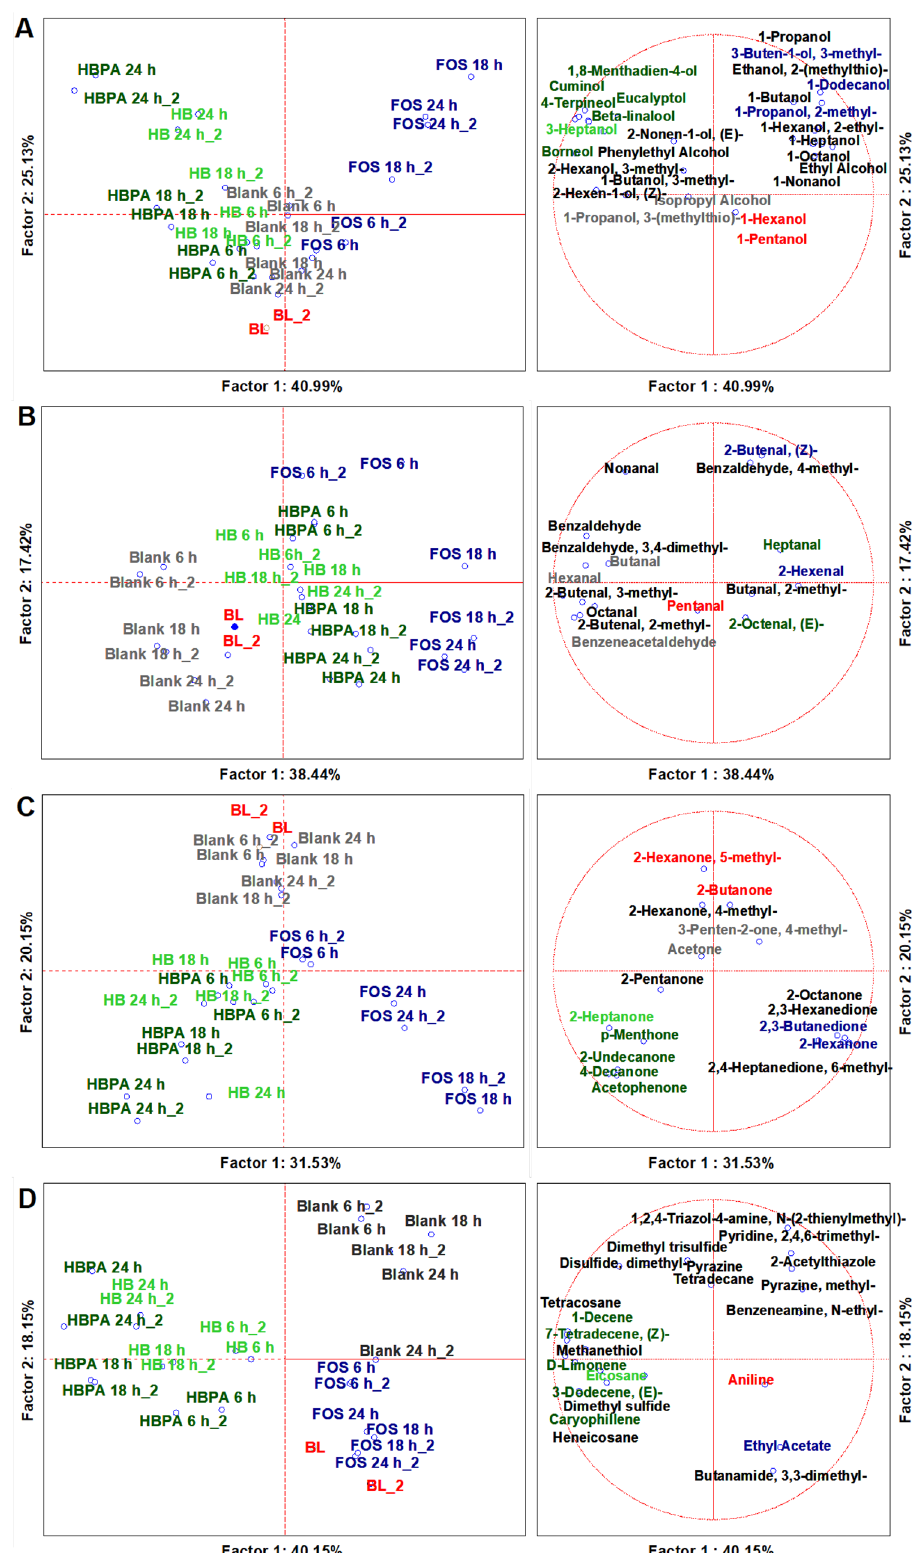
Figure 4. PCAs of the volatilome sorted by chemical classes of significant (ANOVA p < 0.05) VOCs, including the biological replicas of HBPA, HB, FOS, the blank control, and the baseline (BL) and three different timepoints (6 h, 18 h, 24 h). ( A ) Alcohols; ( B ) Aldehydes; ( C ) Ketones; ( D ) Other VOCs. Left side diagrams are for PCAs of cases; right side diagrams are for PCAs of variables. Variables with different colors are the main descriptors of the respective group of cases by MANOVA with categorical predictors as “Time Effect “ and “Matrix Effect” (Table S5, S6). HB Hempseed bran; HBPA HB protein extract hydrolyzed by alcalase; FOS fructooligosaccharides; Blank Blank control; _2 Biological